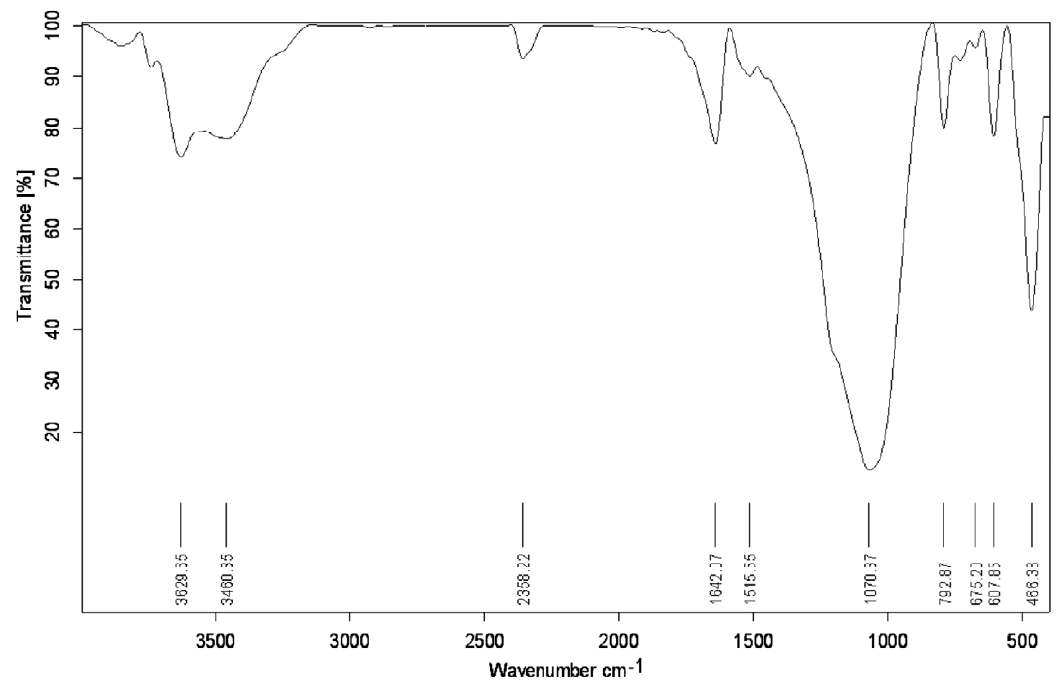
Fig. 2. FT-IR spectrum of zeolite type of